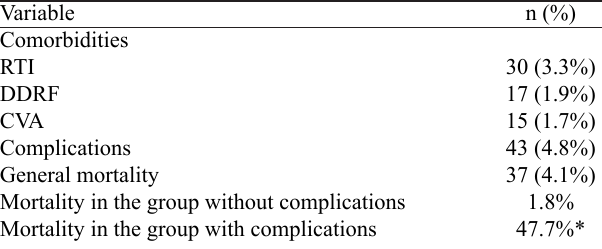
Table 1. Incidence of complications and